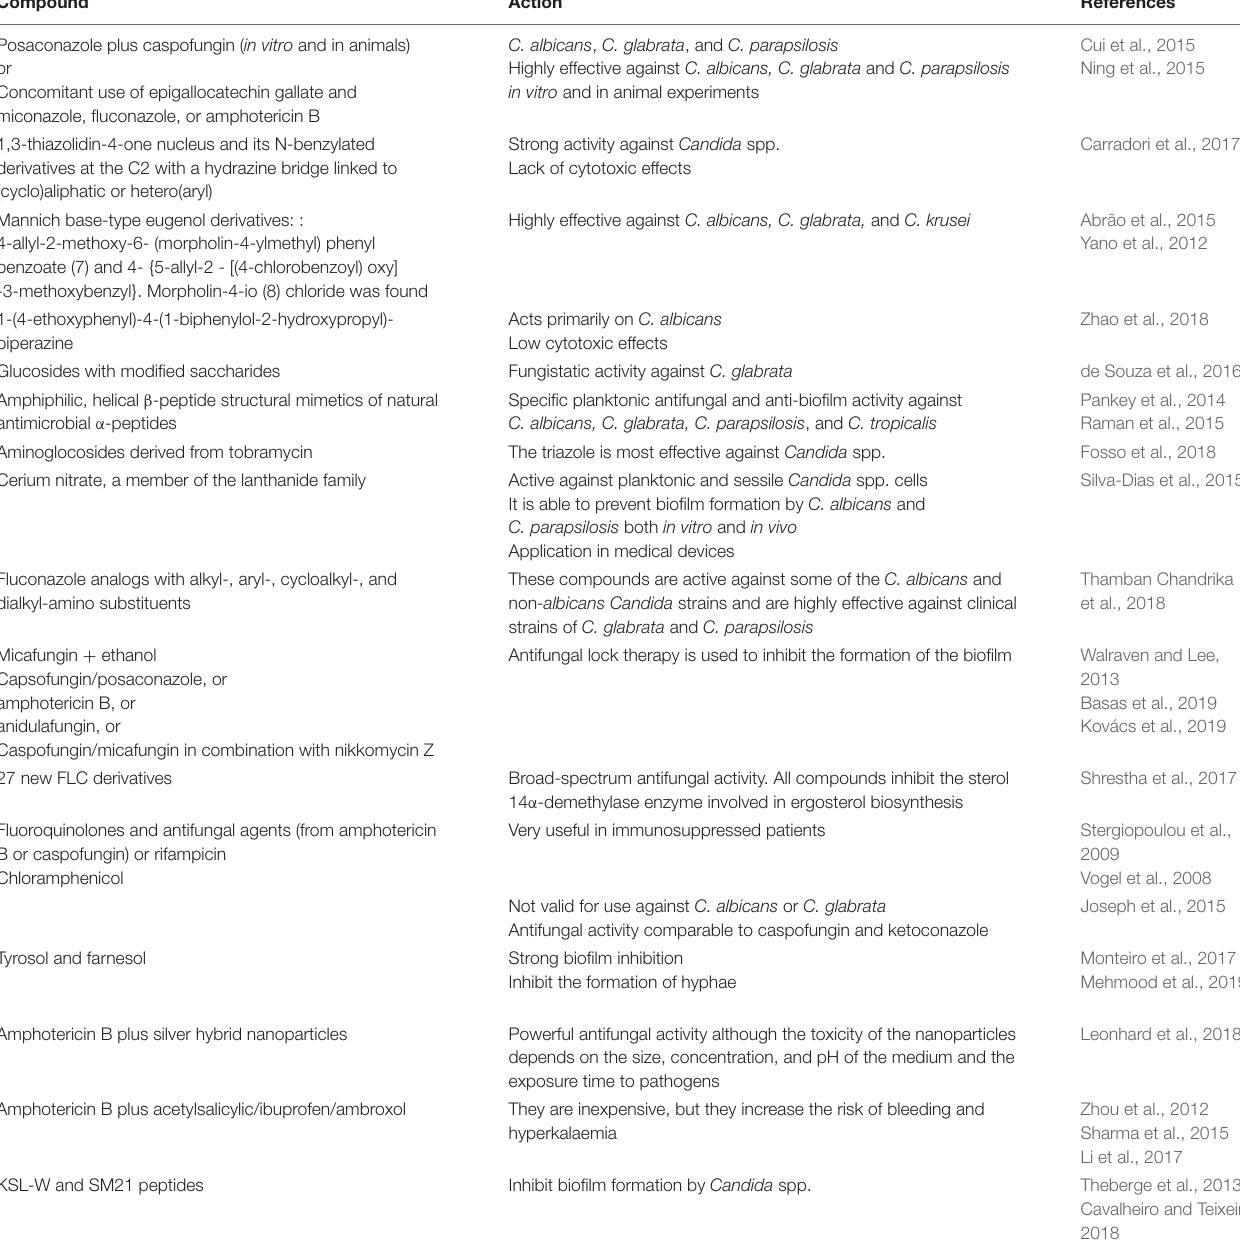
TABLE 5 | New anti- Candida spp. biofilm